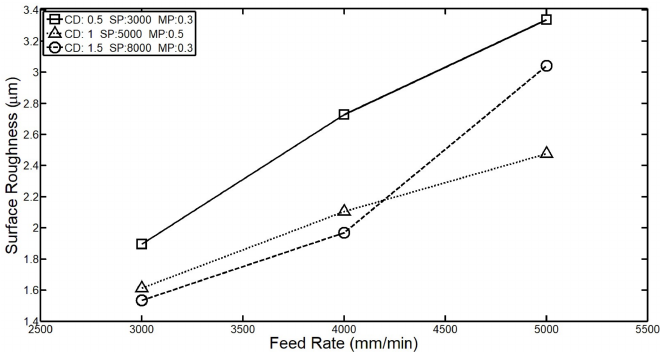
Figure 5. The influence of feed on surface roughness.